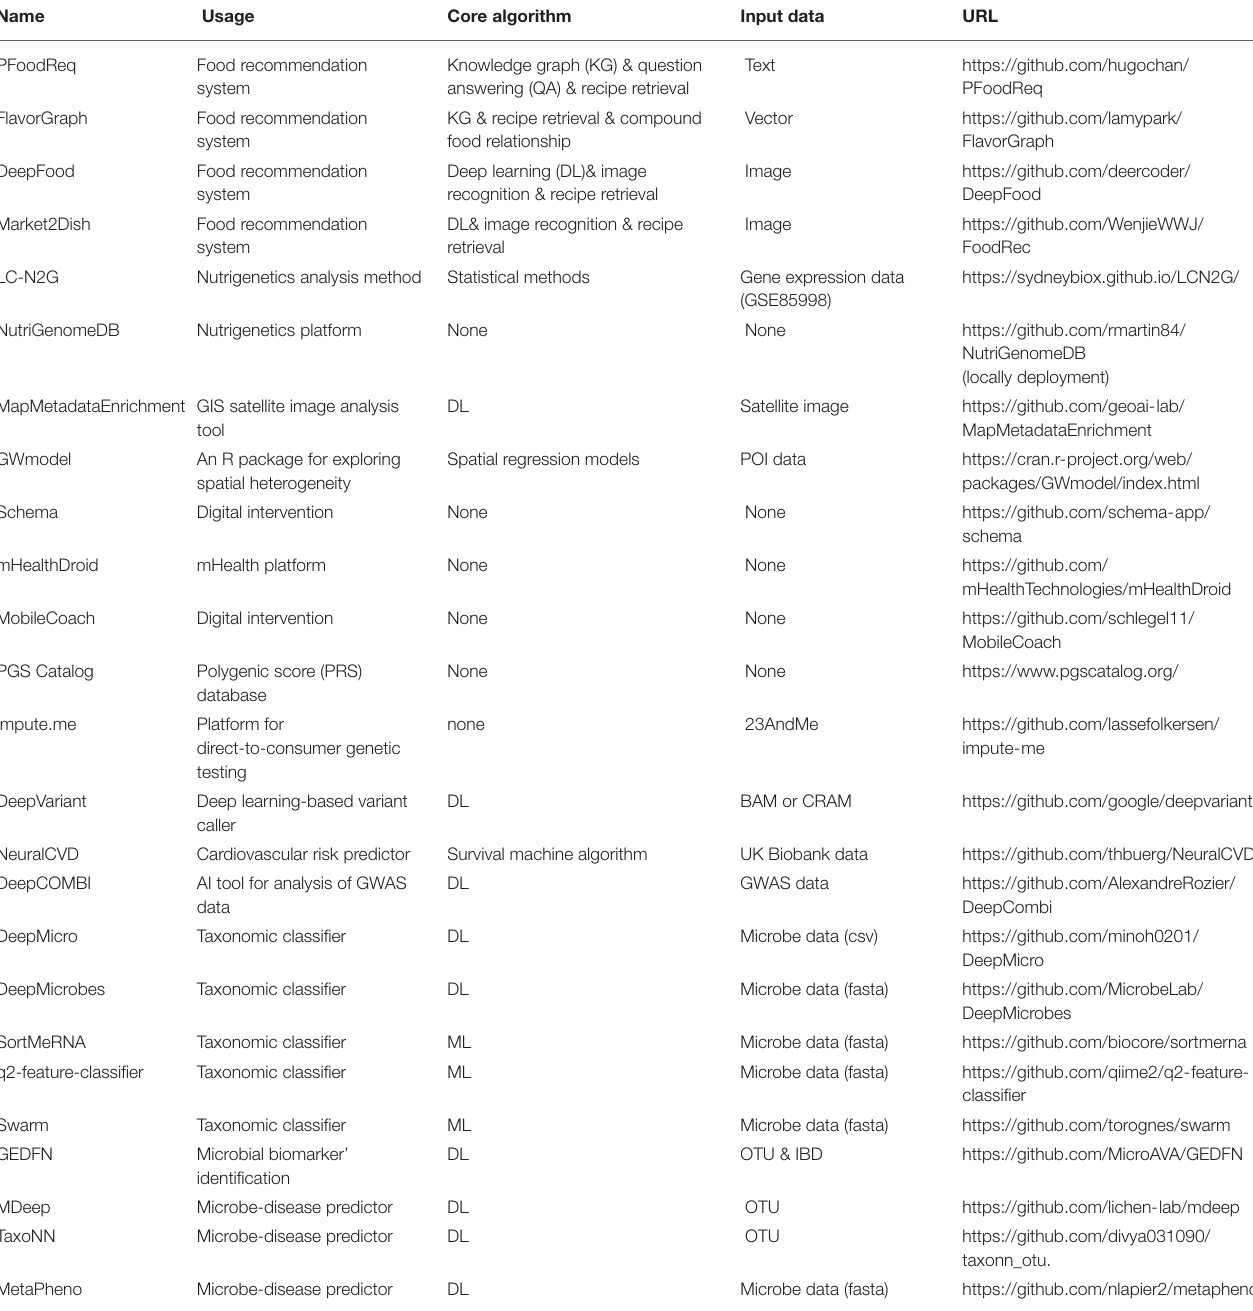
TABLE 1 | Detailed information on these ML